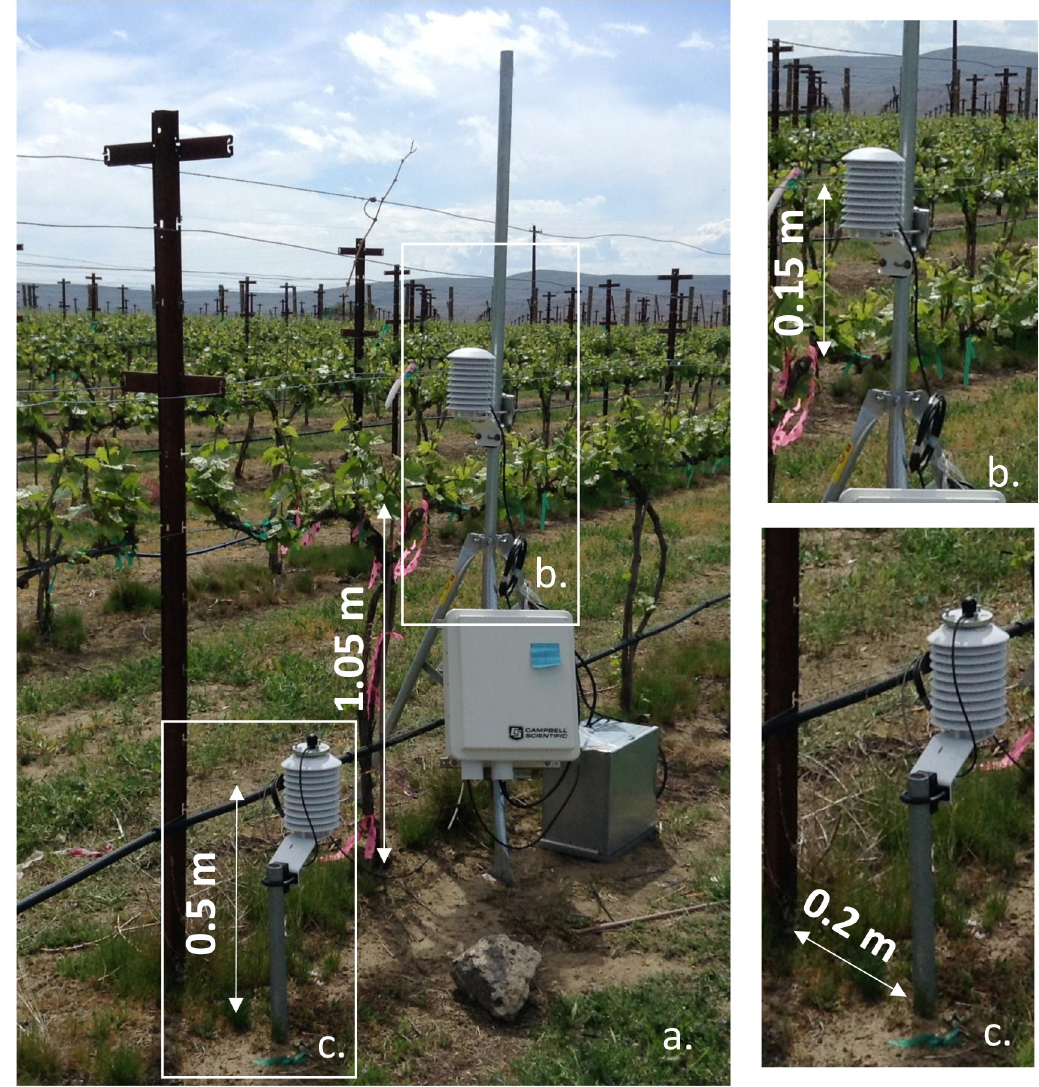
Fig 1. Temperature measurements within the vineyard (a). Temperature probes were installed at a height of 1.2 m above the soil surface and 0.15 m above the cordon (b) and at a height of 0.5 m above the soil surface and separated 0.2 m from the vine rows